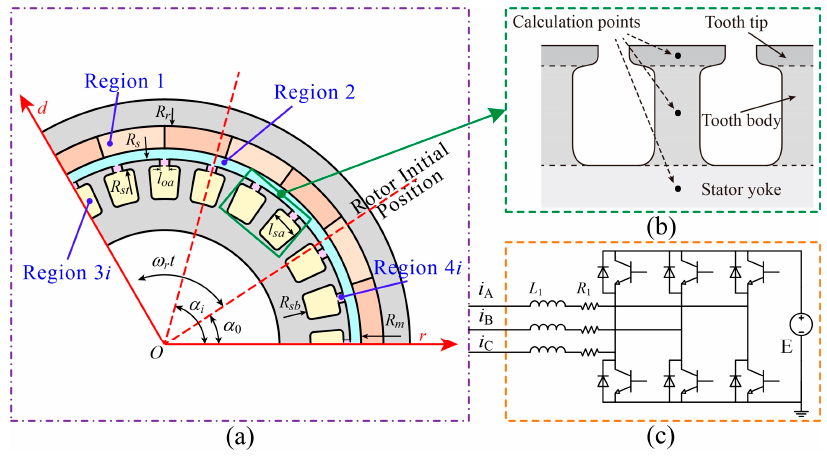
Figure 2. Subdomain model of magnetic field: ( a ) Subdomain distribution; ( b ) Stator structure; ( c ) Inverter circuit.